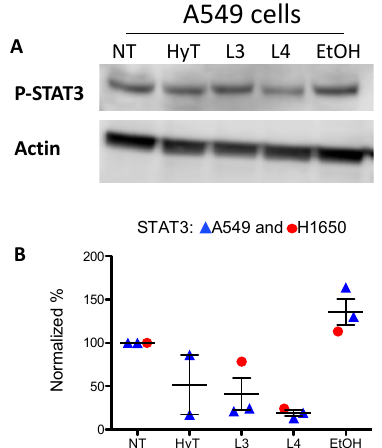
Figure 7. Effects of A009 on STAT3 activation in human lung cancer cells. The A549 cells were treated with two different batches (L4 and L3), 1:250 dilution or HyT, at the same concentration present in A009 dilution for 24 h with A009. Detection of STAT3 phosphorylation (Tyr705) was revealed by western blot analysis. Specific protein band intensity was detected with Pierce ECL Western Blotting Substrate (ThermoFisher Scientific). Protein expressions were normalized to beta-Actin or tubulin. Band intensity (revealed as optical density-OD) were detected by ImageJ software v1.52, and the plot on the lower panel indicates the of levels p-STAT3 in the various conditions. Quantification of results are shown in panel B.